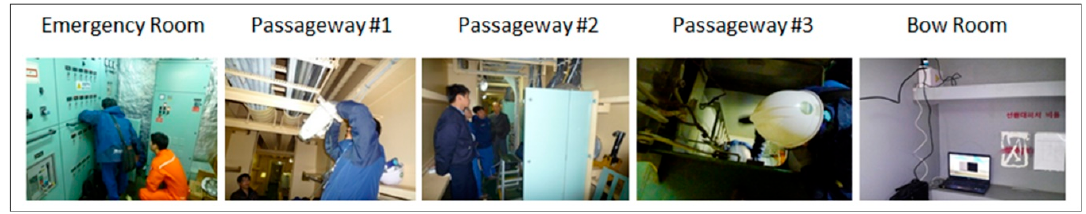
Figure 16 . Ship power line communication installation process. Figure 16. Ship power line communication installation